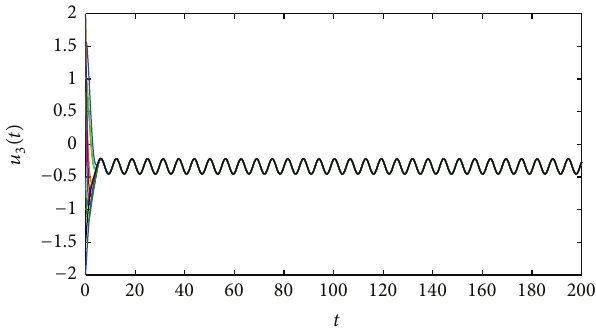
Figure 1: Transient response of state variables 𝑢 1 (𝑡) of Example 1.